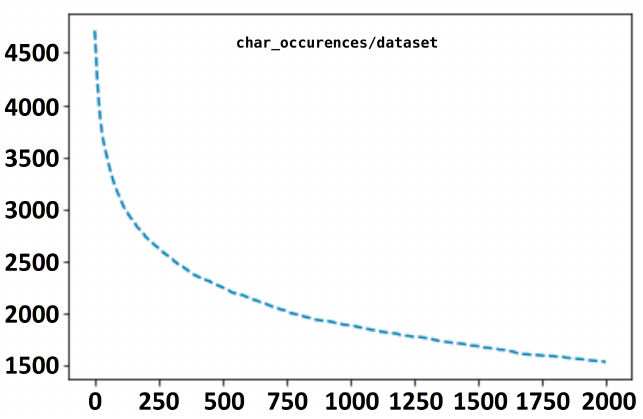
Figure 6. Visual representation of character appearances in the generated training